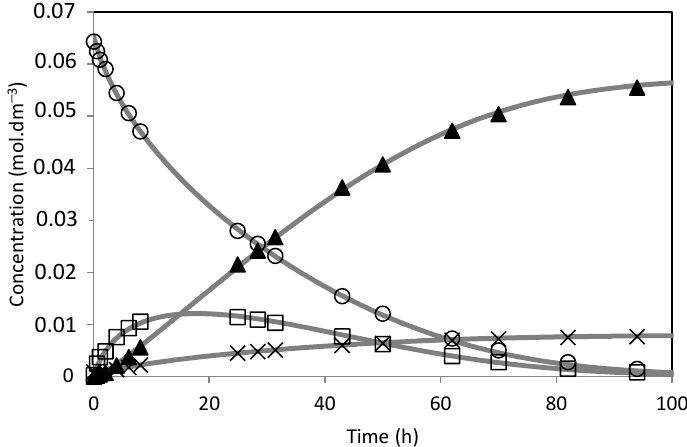
Figure 17. Camphene hydration over PW3‑SBA‑15‑SO 3 H catalyst. ( # ) Camphene; ( □ ) Camphene hydrate; ( ▲ ) Isoborneol; ( × ) Others. The lines represent the model fitted to the experimental points.